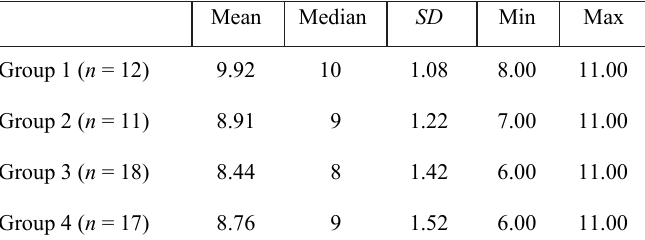
Table 2. Results of the word meaning structure